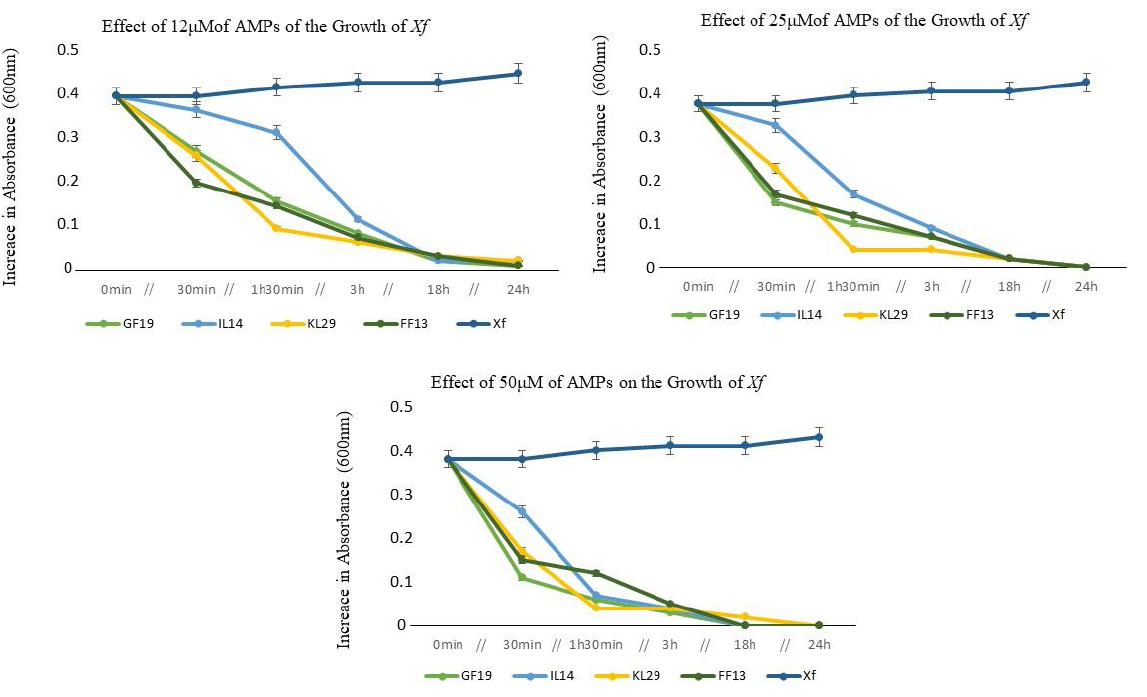
Figure 2. Optical density values showing the AMPs’ inhibitory activity against Xf cells, at different concentrations. The curves show means of three replicates per treatment.